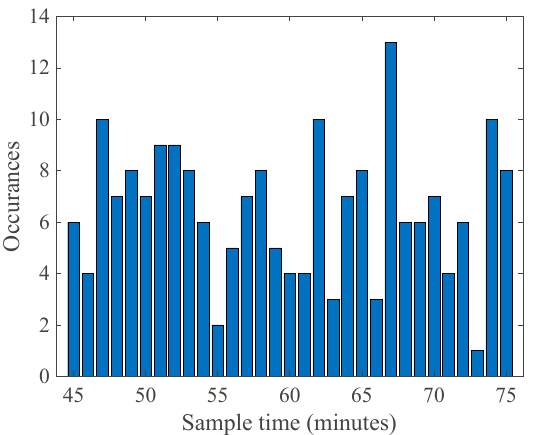
Figure 6. The sample time variations between 45 and 75 min.